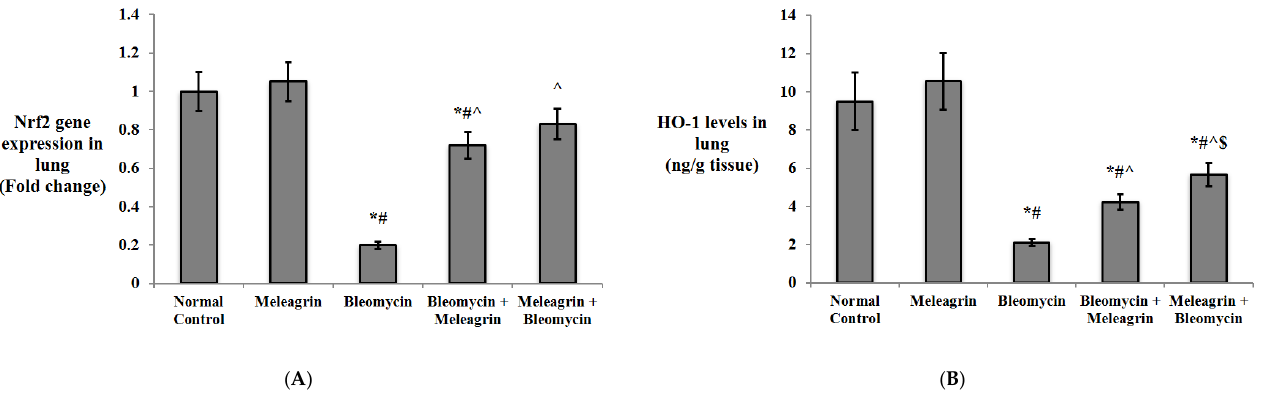
Figure 4. The effect of meleagrin on the Nrf2/HO-1 pathway: ( A ) the gene expression of Nrf2, and ( B ) the levels of HO-1 in the lung tissue of the experimental mice. Nrf2 = nuclear factor-erythroid factor 2-related factor 2; HO-1 = heme oxygenase-1. Data are expressed as mean ± SD and analyzed using one-way ANOVA followed by Bonferroni’s post hoc test ( n = 8). * significantly different vs. the normal control group; # significantly different vs. the meleagrin group; ^ significantly different vs. the bleomycin group. $ significantly different vs. the bleomycin + meleagrin group. Differences were considered significant at p < 0.05.